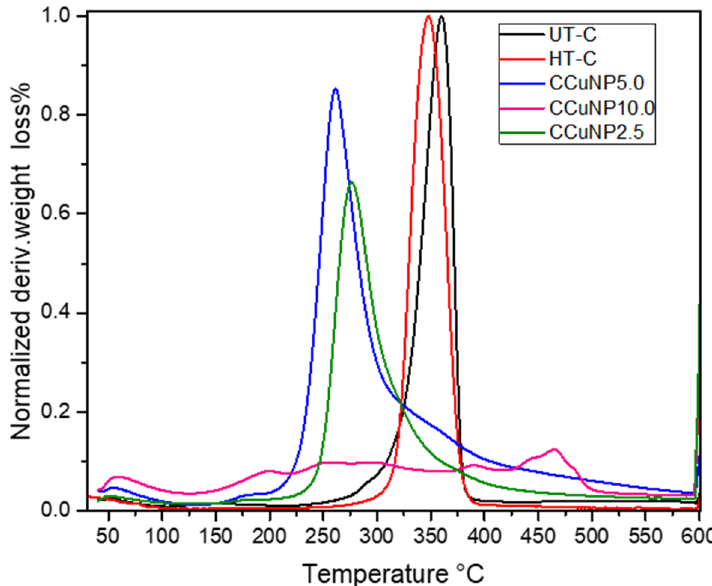
Figure 3. DTA curves of copper nanoparticles/cellulose (CCuNP); untreated cellulose (UT-C) and heat-treated cellulose (HT-C).